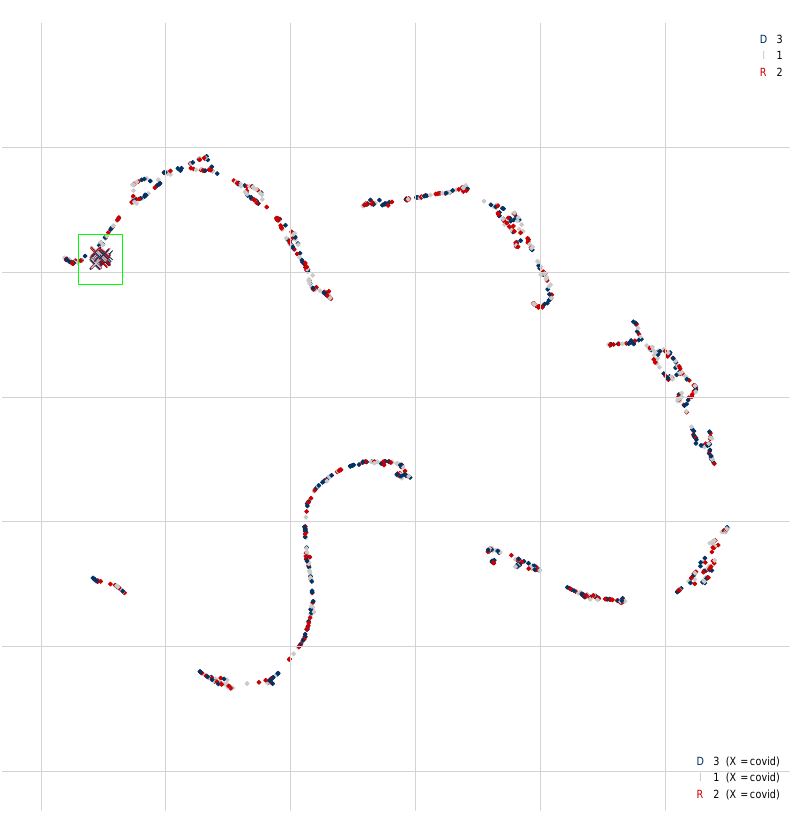
Fig. 4 Projecting COVID onto pre-COVID